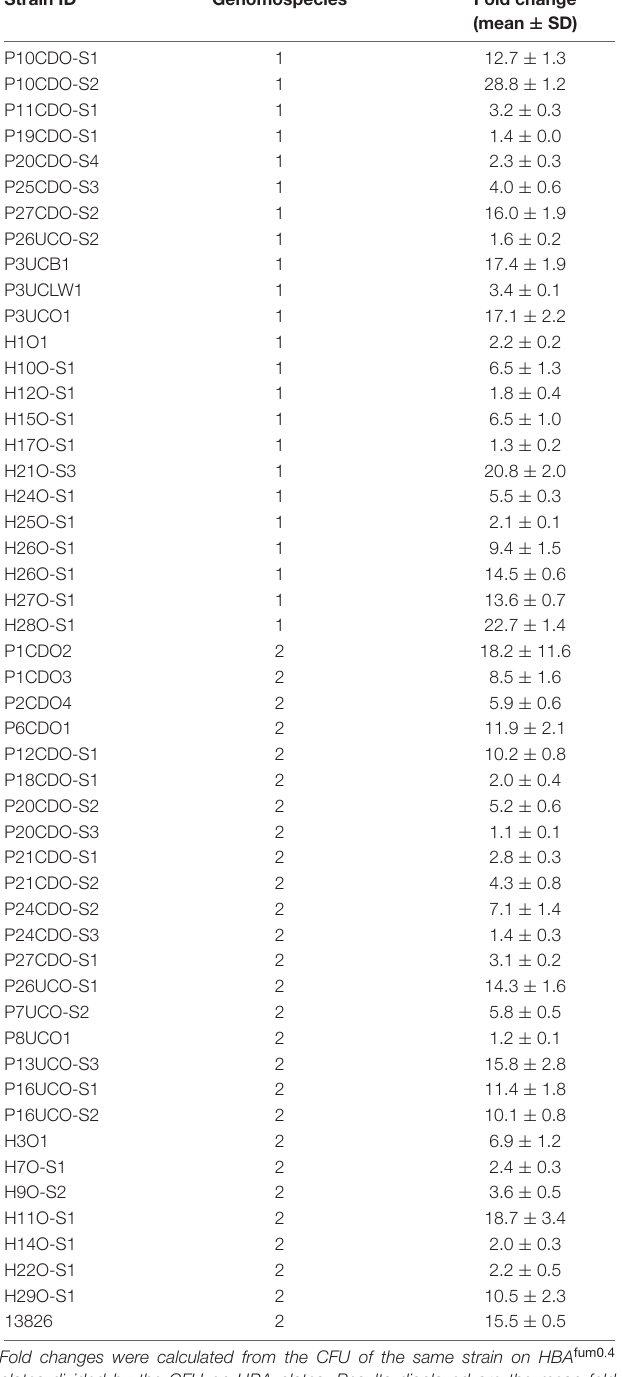
TABLE 3 | CFU fold changes of all 50 strains of C. concisus cultured on HBA fum 0 . 4 compared to HBA plates. Strain ID Genomospecies